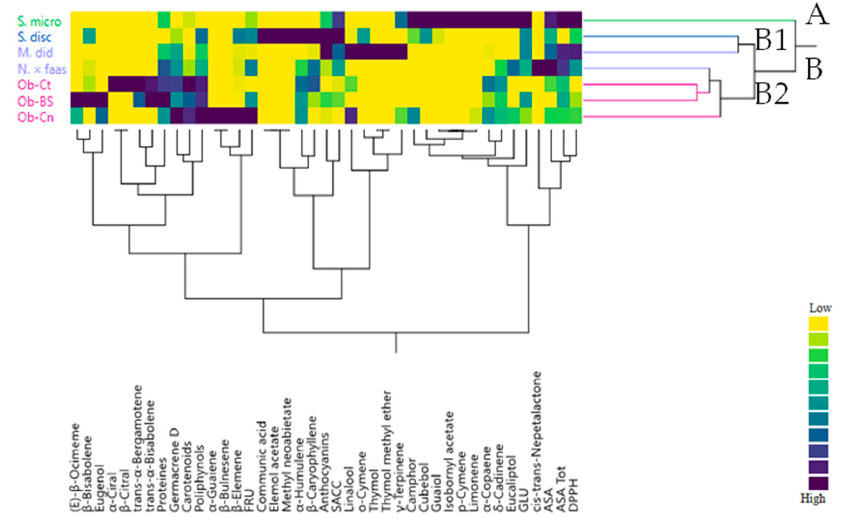
Figure 4. Dendrogram of cluster hierarchical analysis performed on VOCs from the studied Lamiaceae species.